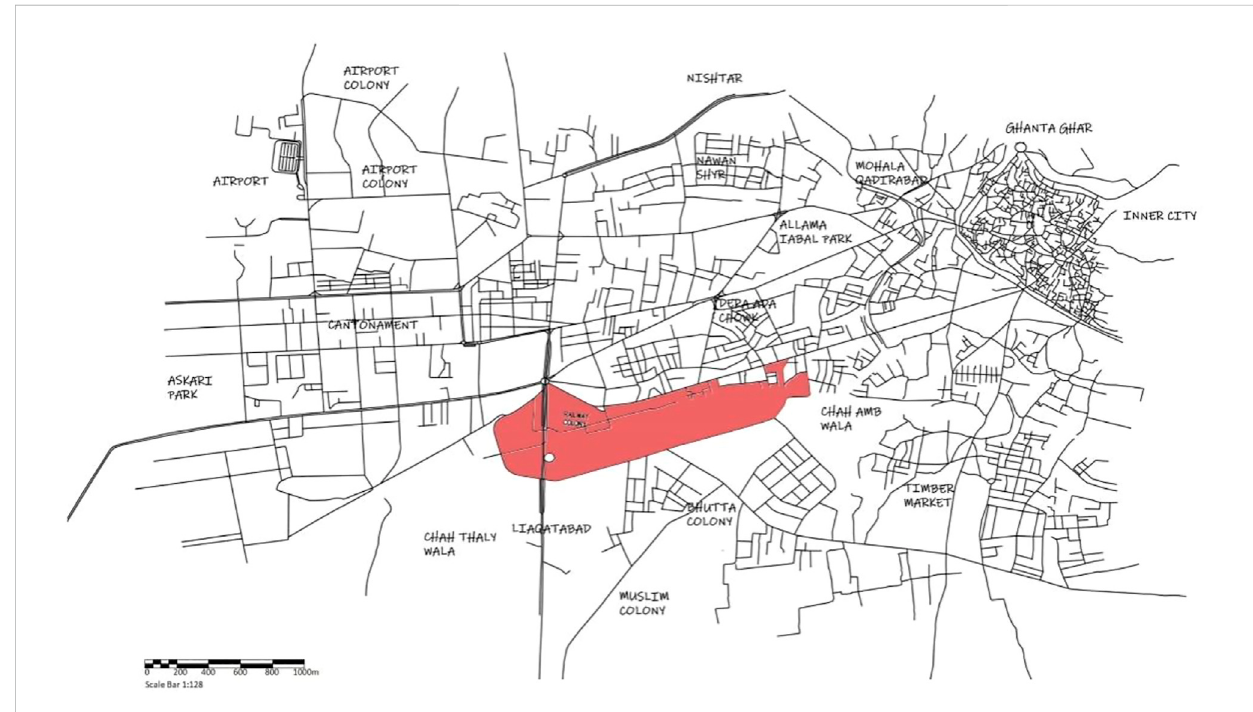
Urban void under fl yover at the Railway Colony, Multan.